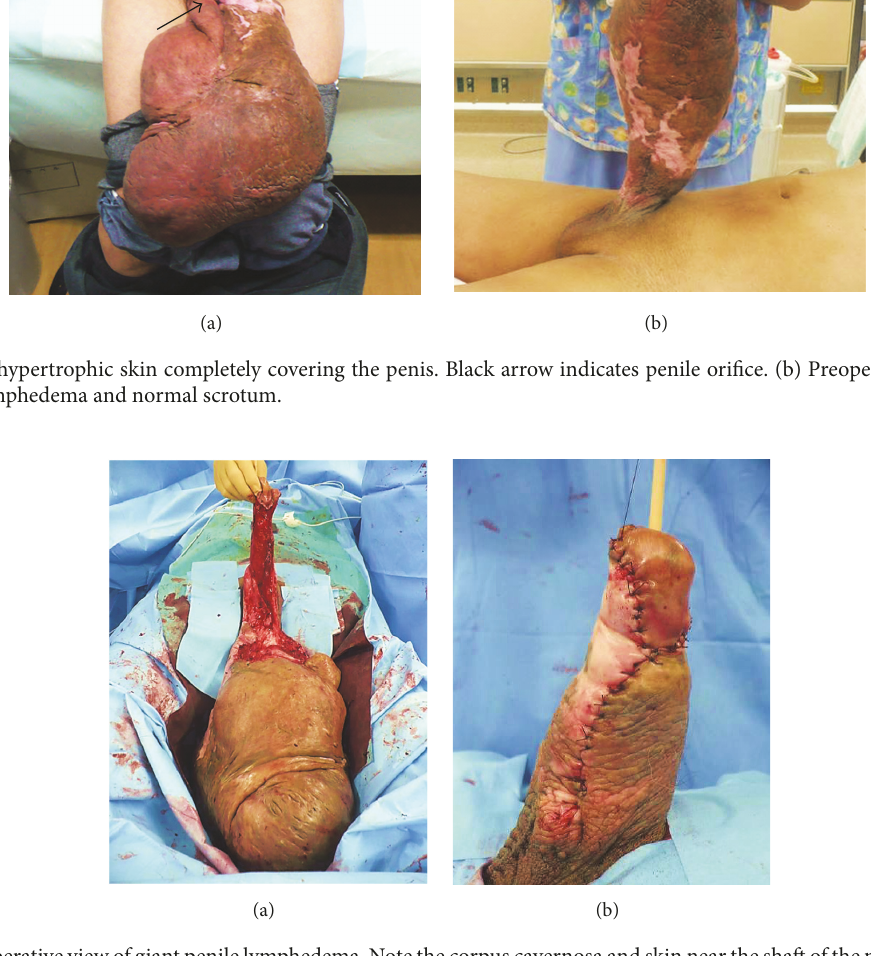
Figure 2: (a) Intraoperative view of giant penile lymphedema. Note the corpus cavernosa and skin near the shaft of the penis remained intact. (b) Postoperative results. Note that skin from near the penile shaft was used to cover the